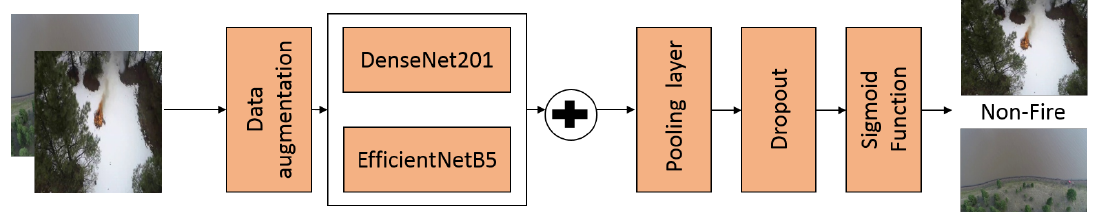
Figure 1. The proposed architecture for wildfire